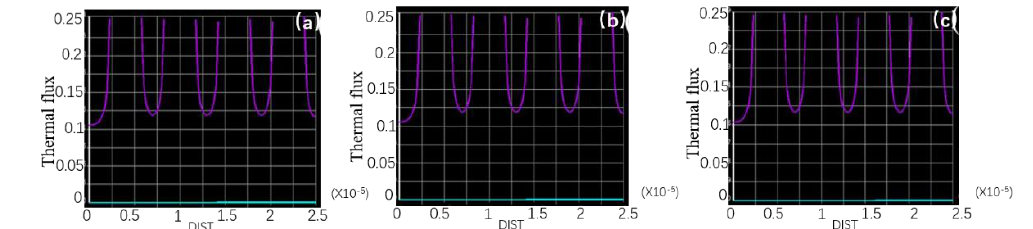
Figure 6. Thermal flux of coatings without splat interface ( a ) M 1 , ( b ) M 2 and ( c ) M 3 .